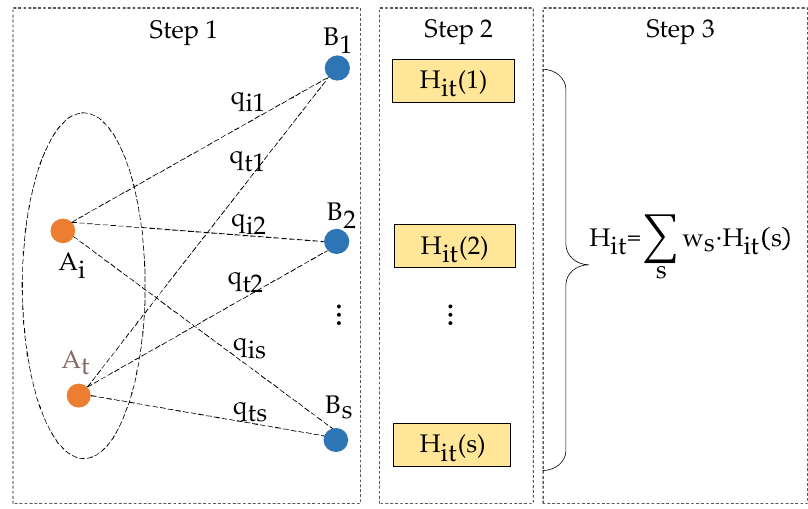
Figure 2. Homogenization of the flight quantity between an airport in the MAR and its connected airports.